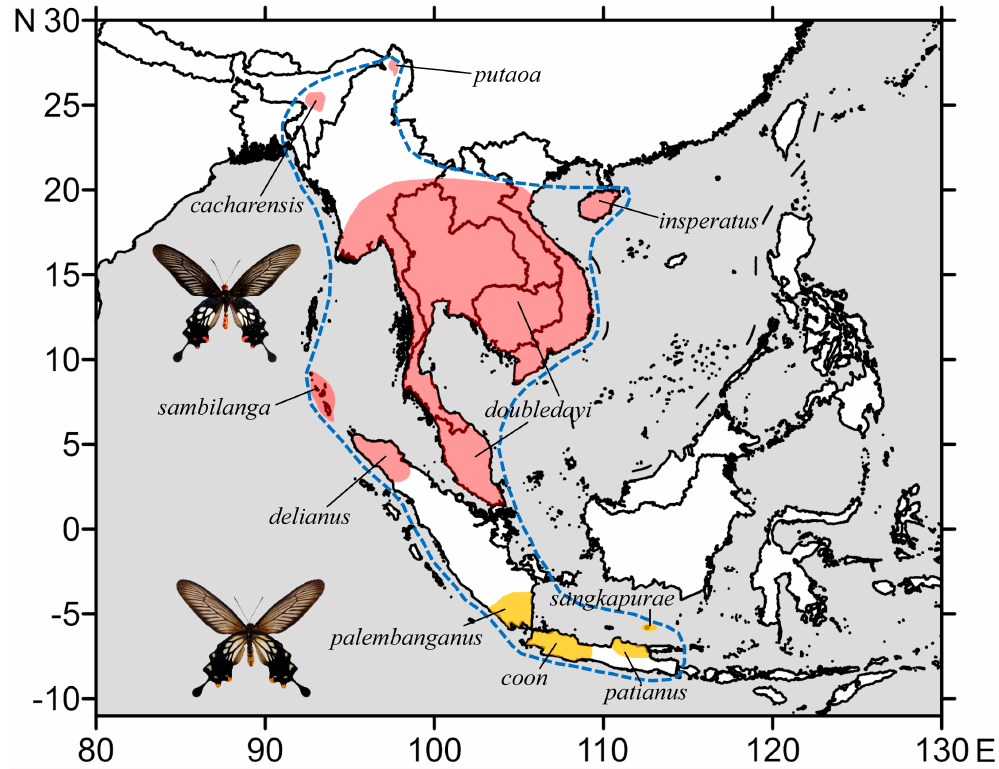
Figure 1. Distribution of the yellow and red marked Losaria coon (Fabricius, 1793), with currently accepted subspecies delimitation; the blue dash line encircles the tentative distribution range of L. coon . The yellow and red marked coon are separated from each other geographically, even in Sumatra, where the yellow marked ssp. palembanganus and the red marked ssp. delianus are not sympatric, according to available records, as shown in Figure 1. The constant morphological di ff erences coupled with this distribution pattern leave an unanswered question—whether the yellow and red marked coon really belong to the same